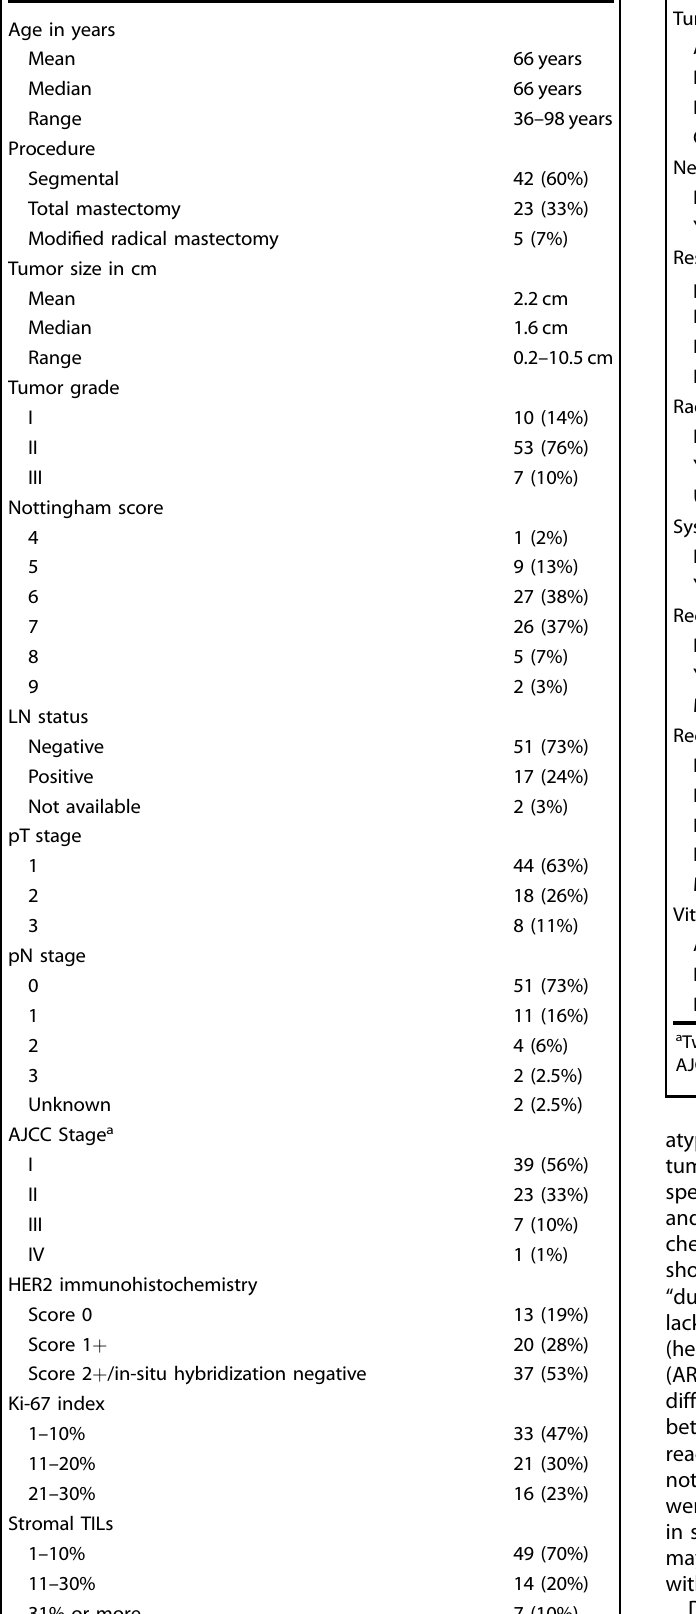
Table 1. Patient and tumor characteristics ( n =